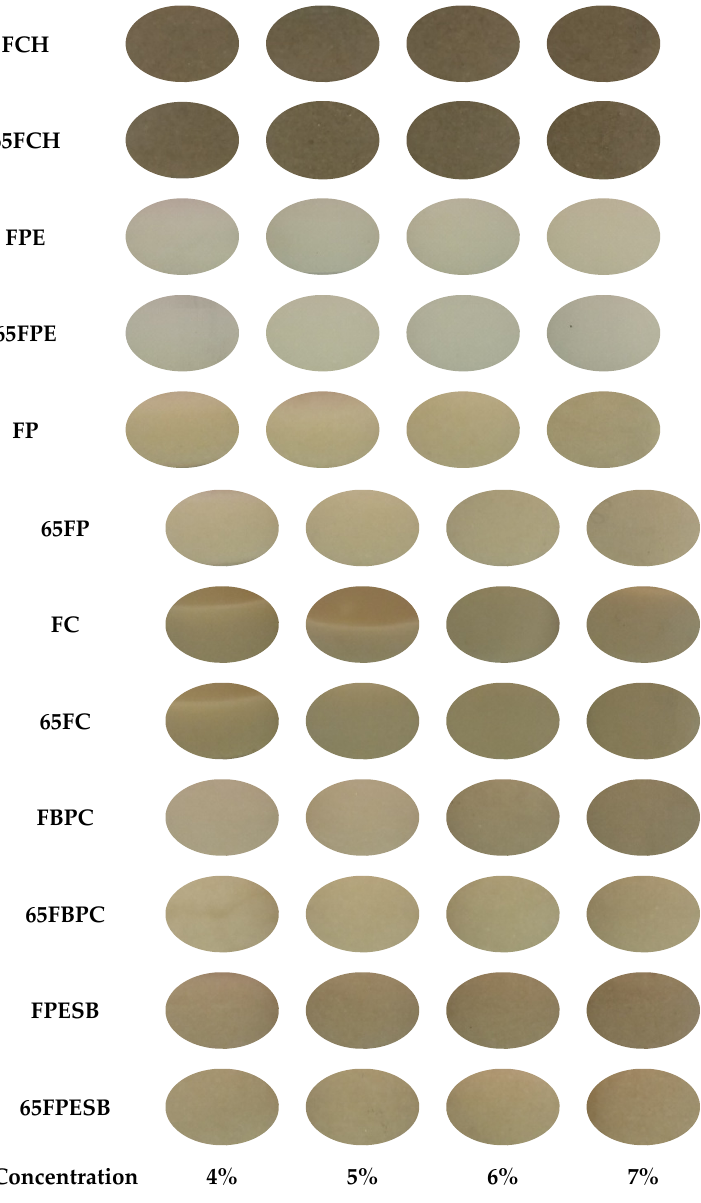
Figure 5. Color gel images at the tested concentrations.